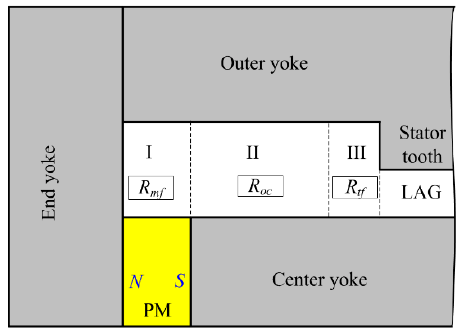
Figure 3. Magnetic flux leakage inside the RCDMC.